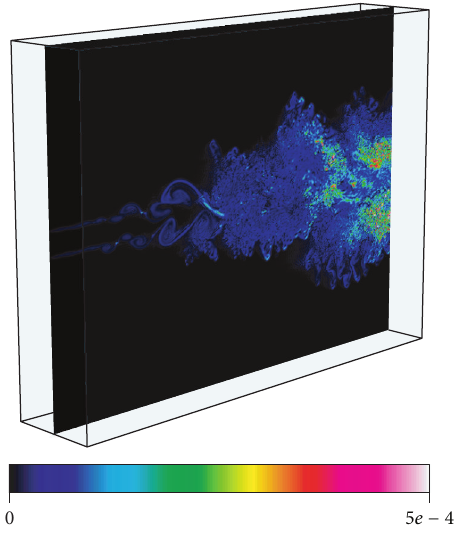
0 Figure 2: Instantaneous contour of the TiO 2 mass fraction at 𝑧 = 0 plane at 𝑡 ⋆ = 100